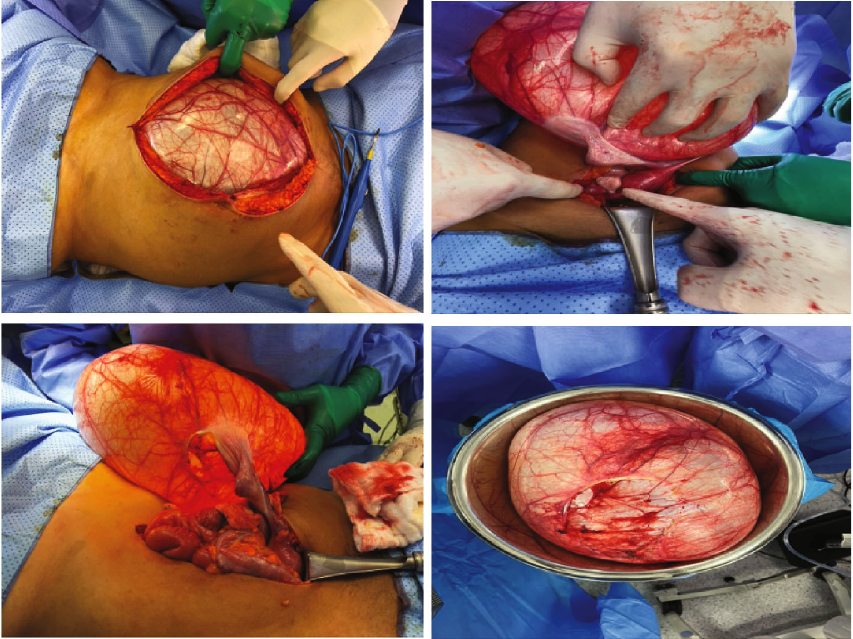
Figure 4: Intraoperative fi ndings of left huge paratubal cystic